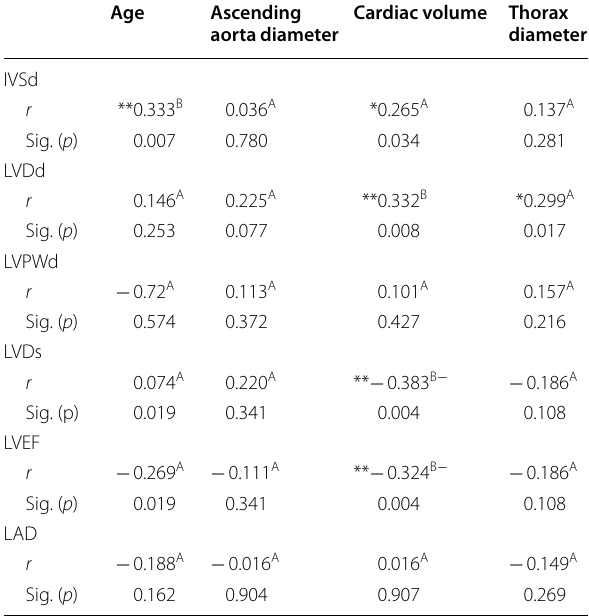
Table 6 Pearson correlations between morphologic and echocardiography